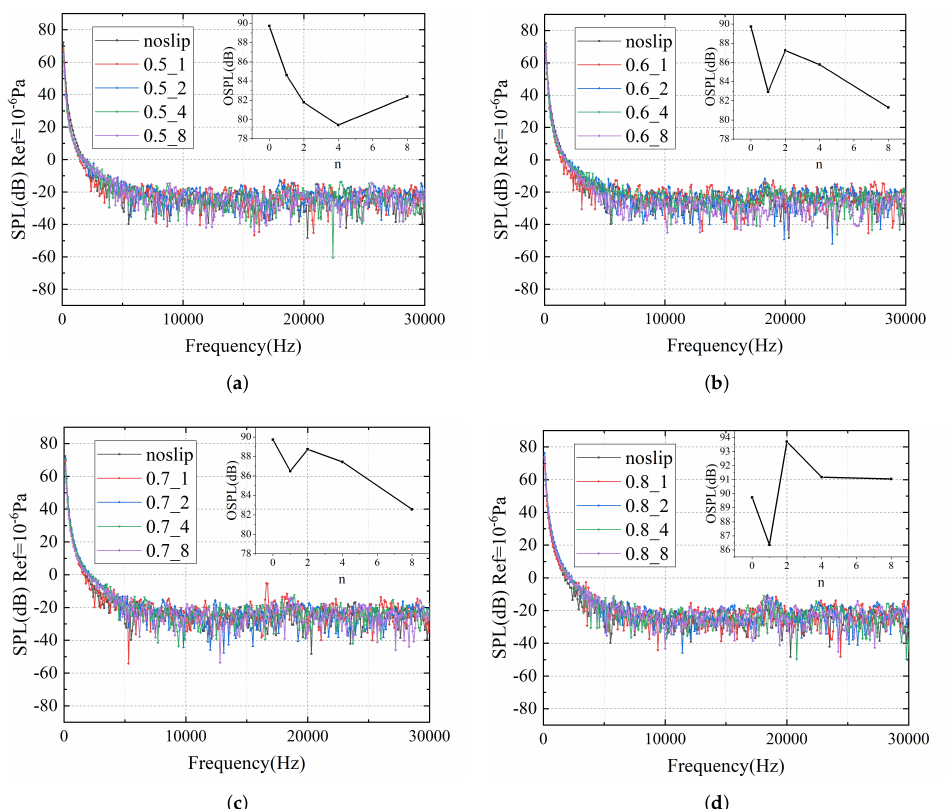
Figure 15. Comparison of frequency spectra for different strips number at GF =